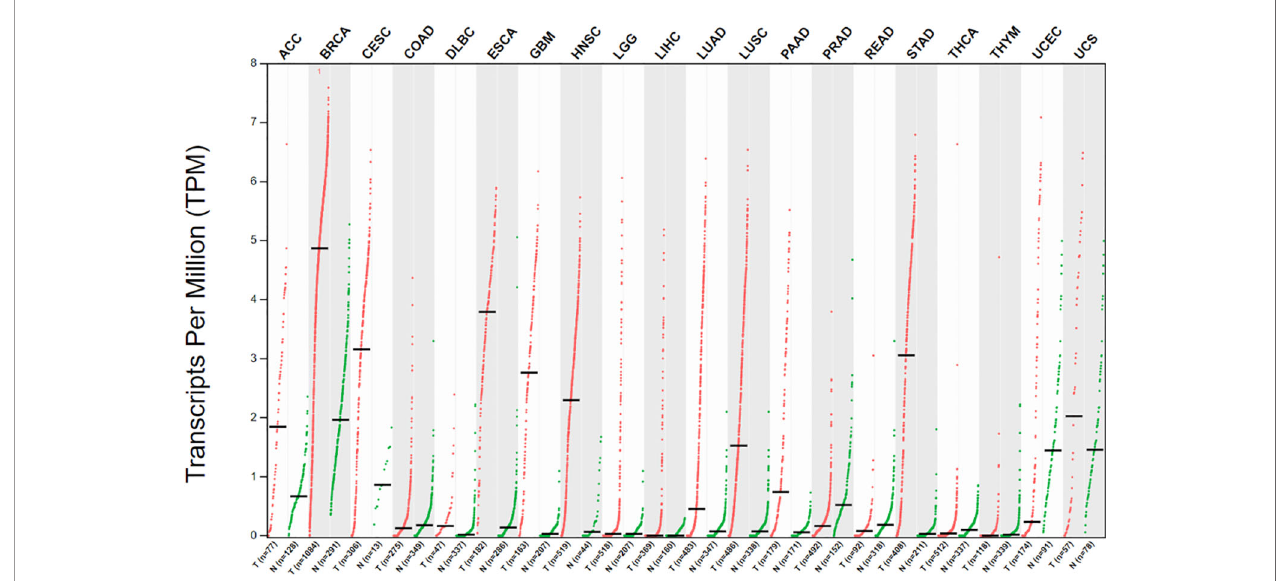
FIGURE 2 | Dot plot showing different HOXC10 expression across 20 tumor samples and paired normal tissues. Each dots represents expression of samples. (X- axis: cancer type, Y-axis: log2[TPM + 1]) Tumors data are from the Cancer Genome Atlas (TCGA), and normal data are from the TCGA and GTEx database. Data were visualized using GEPIA2.0 (http://gepia2.cancer-pku.cn/).